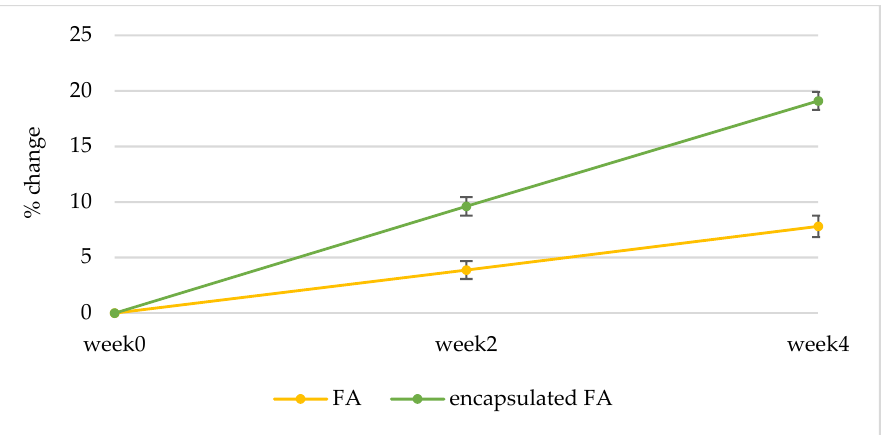
Figure 13. Percent of change in skin elasticity (R2) of 16 volunteers after application of FA and encapsulated FA creams.